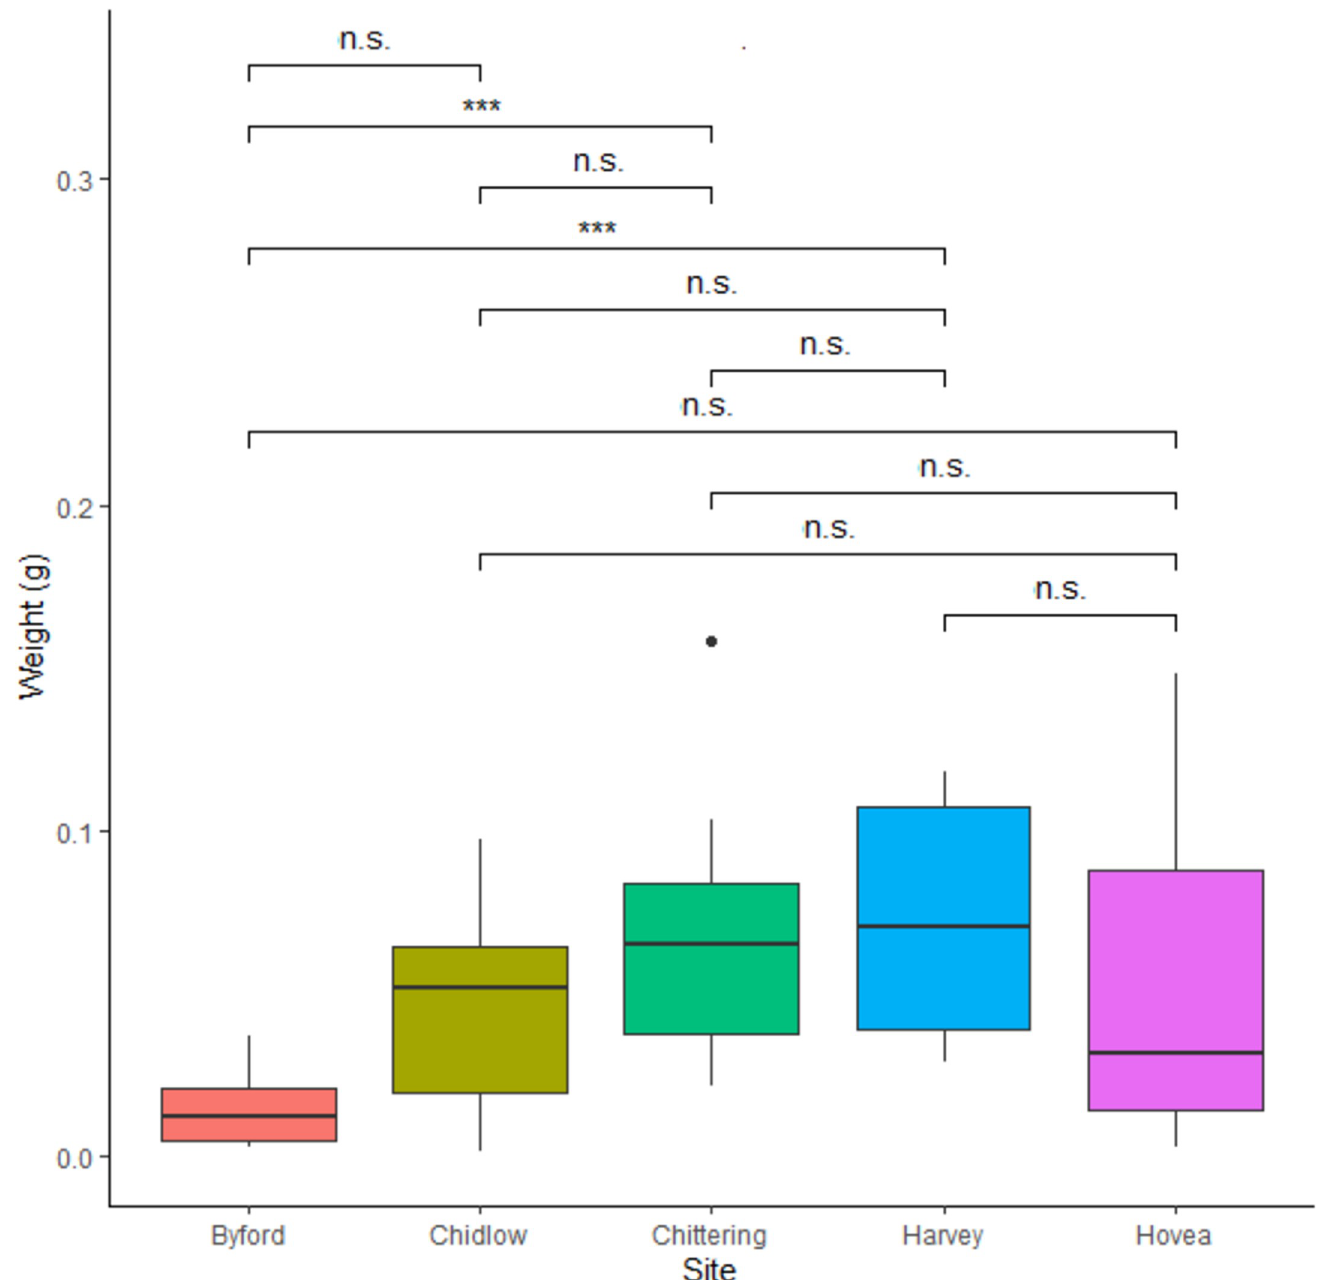
Fig 4. Weight of bee venom samples per study sites. Weight in g; medians and standard deviation are shown. https://doi.org/10.1371/journal.pone.0253838.g004 whereas the lowest was from Byford (mean ± SD, 0.014 g ± 0.011) (Fig 4; S4 Table). Variation of BV’s weight among sites was found only between Chittering and Byford (p = 0.013) and between Harvey and Byford (p = 0.0084). The principal component analyses based on site (S1 Fig) indicated that the first two axes could explain 56.1% of the protein variation between samples, 42.5% by axis 1 and 13.6% by axis 2. The most compact cluster was associated with the Chittering site, while BVs from the Byford site showed the most dispersed distributional